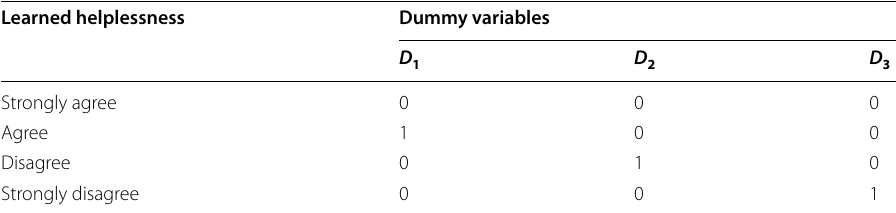
Table 5 Dummy variables for learned helplessness Learned helplessness Dummy variables D 1 D 2 D 3 Strongly agree 0 0 0 Agree 1 0 0 Disagree 0 1 0 Strongly disagree 0 0